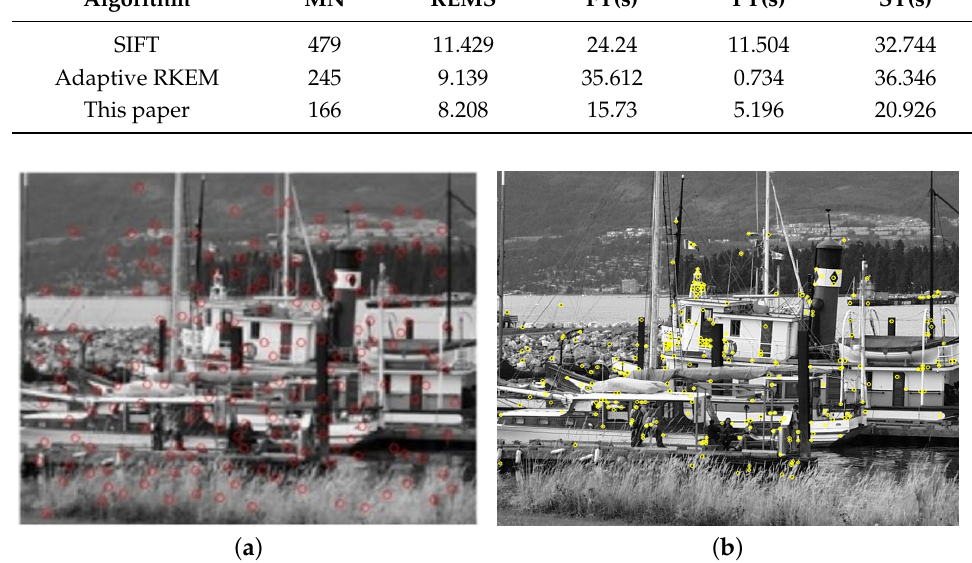
Figure 15. Extraction result of feature points of the reference image. ( a ) The adaptive RKEM algorithm; ( b ) The algorithm in this